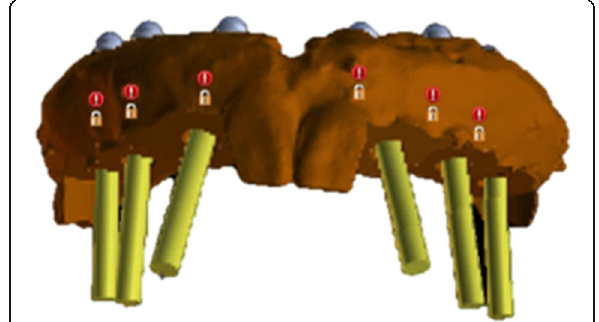
Fig. 3 Implant placement simulation and surgical guide design